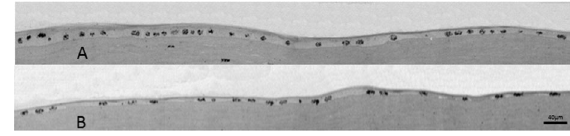
Figure 6. Autoradiography of semithin Epon sections prestained with iron-hematoxylin 36 h after the scraping of the peripheral epithelium plus excision of the corneoscleral zone 2 days prior to sacrifice. These photomicrographs were taken from a single section of the anterior region of the cornea. On the left-hand corner of plate A is the border of the non-scraped epithelium. The right-hand corner of plate B corresponds to the ending border of the newly formed epithelium. In A , on the region where the epithelium is stratified (far left), the [ 3 H]-TdR-labeled nuclei are concentrated in the basal stratum. From this region toward the periphery, the epithelium is monolayered and practically all nuclei are